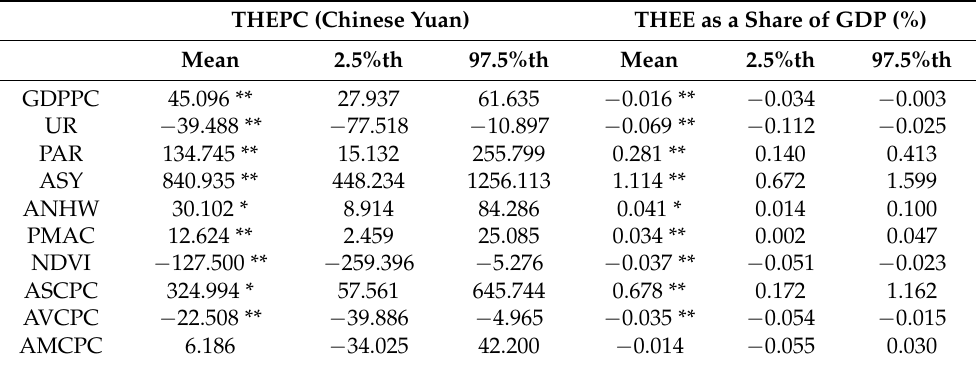
Table 1. The influence factors’ effects on THEPC and THEE as a share of GDP at the national level, estimated by the B-LASSO model. THEPC (Chinese Yuan) THEE as a Share of GDP (%) Mean 2.5%th